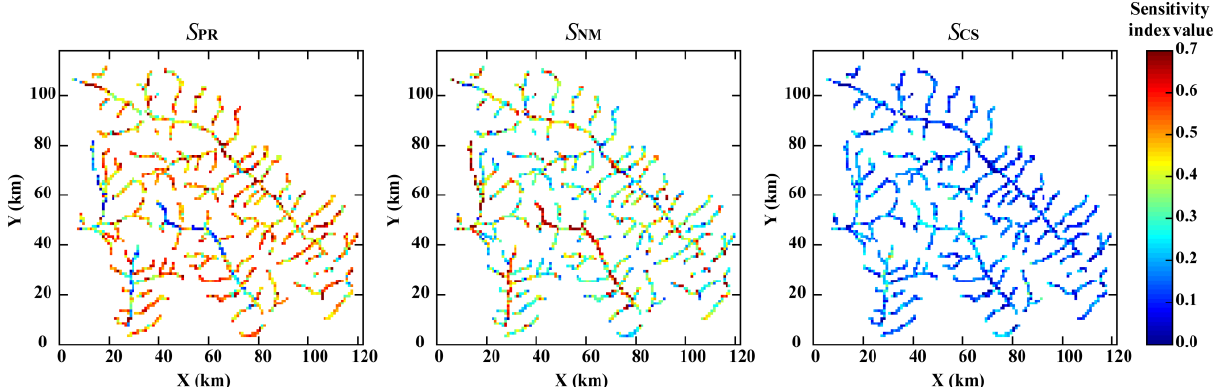
Figure 9. Maps of parametric sensitivity indices ( S PR ), numerical model sensitivity indices ( S NM ), and climate scenario sensitivity indices ( S CS ) for the time-averaged groundwater contribution to stream flow ( Q G )